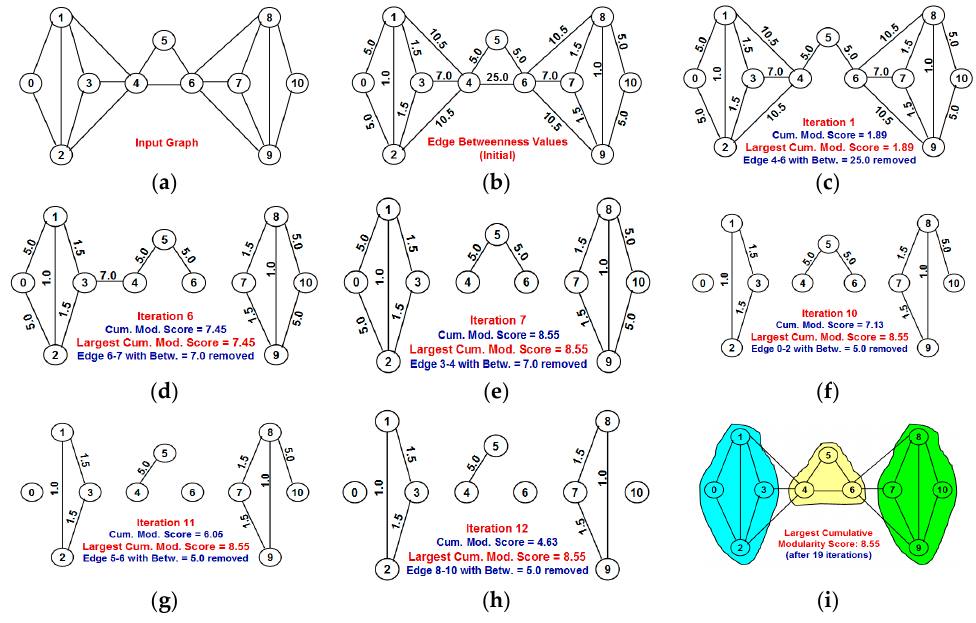
Figure 7. Example to illustrate Girvan-Newman efficient algorithm for edge betweenness-based community detection (initial edge betweenness values used for each iteration). ( a ) Input graph; ( b ) Betweenness values for the edges in the input graph; ( c ) At the end of Iteration 1: Remaining